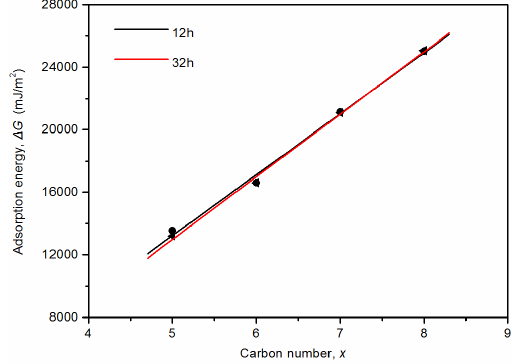
Figure 4: Effect of aging time of column on adsorption energy